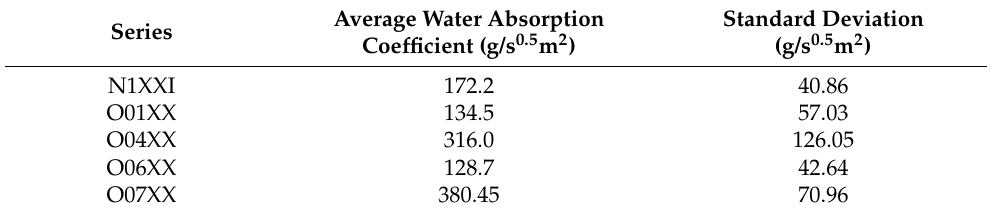
Table 3. Water absorption coefficient average value and standard deviation for selected series.